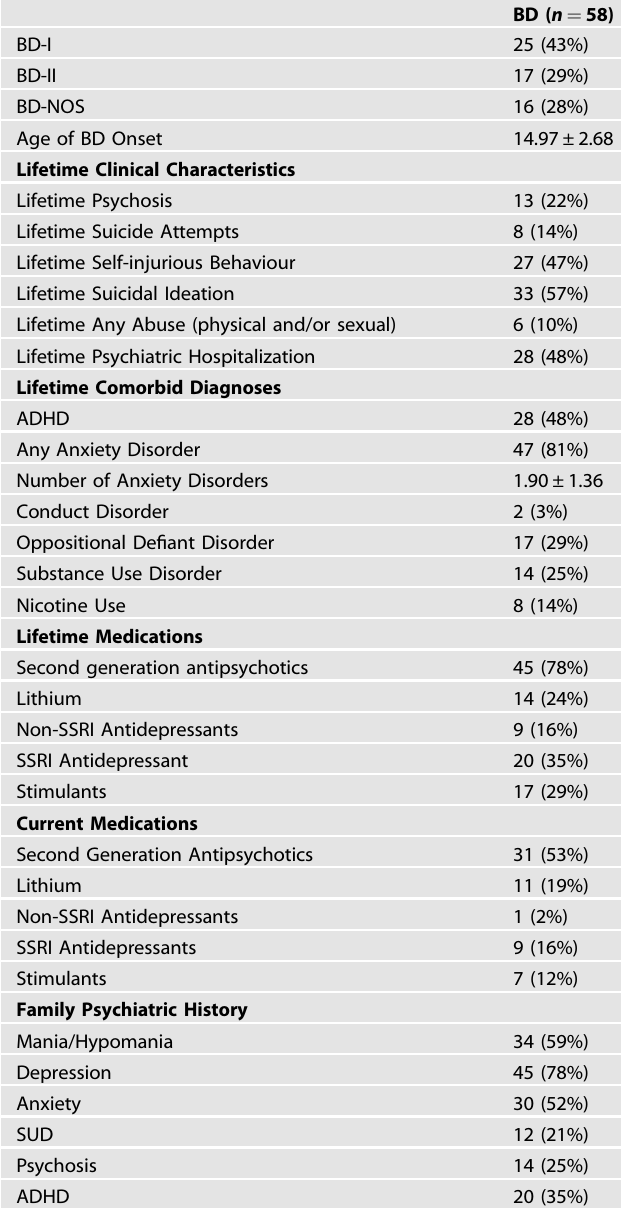
Table 3. Clinical